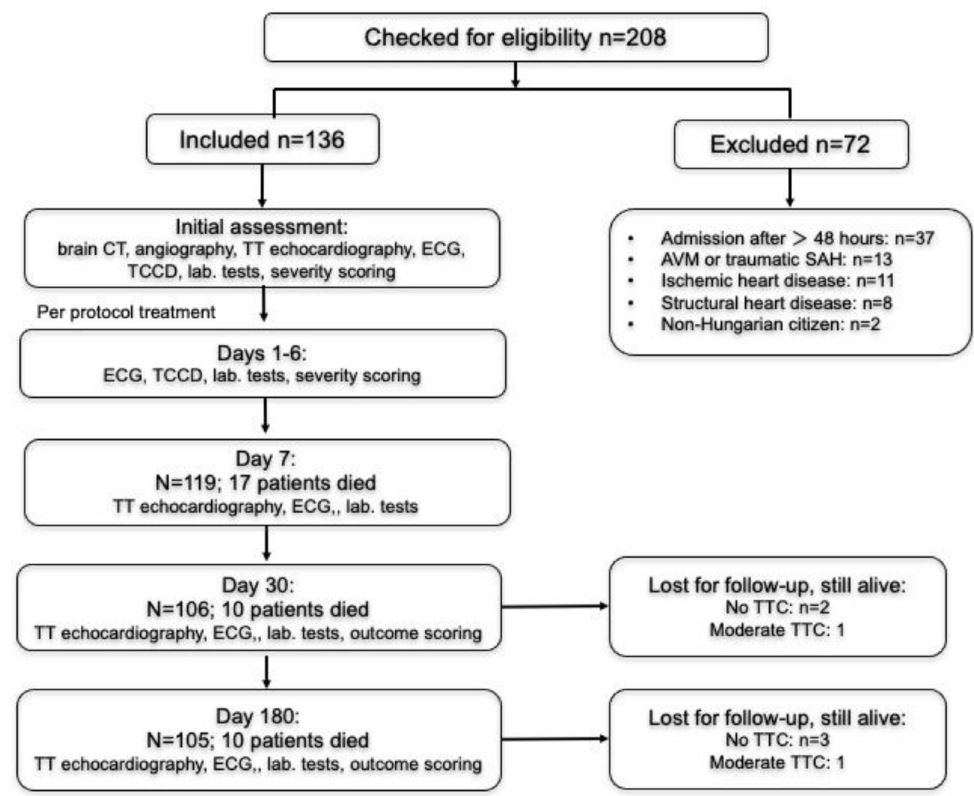
Fig 1. Flowchart of patient inclusion and exclusion. CT indicates computed tomography; TT indicates transthoracic; ECG indicates electrocardiogramm; TCCD indicates transcranial color-coded duplex sonography.